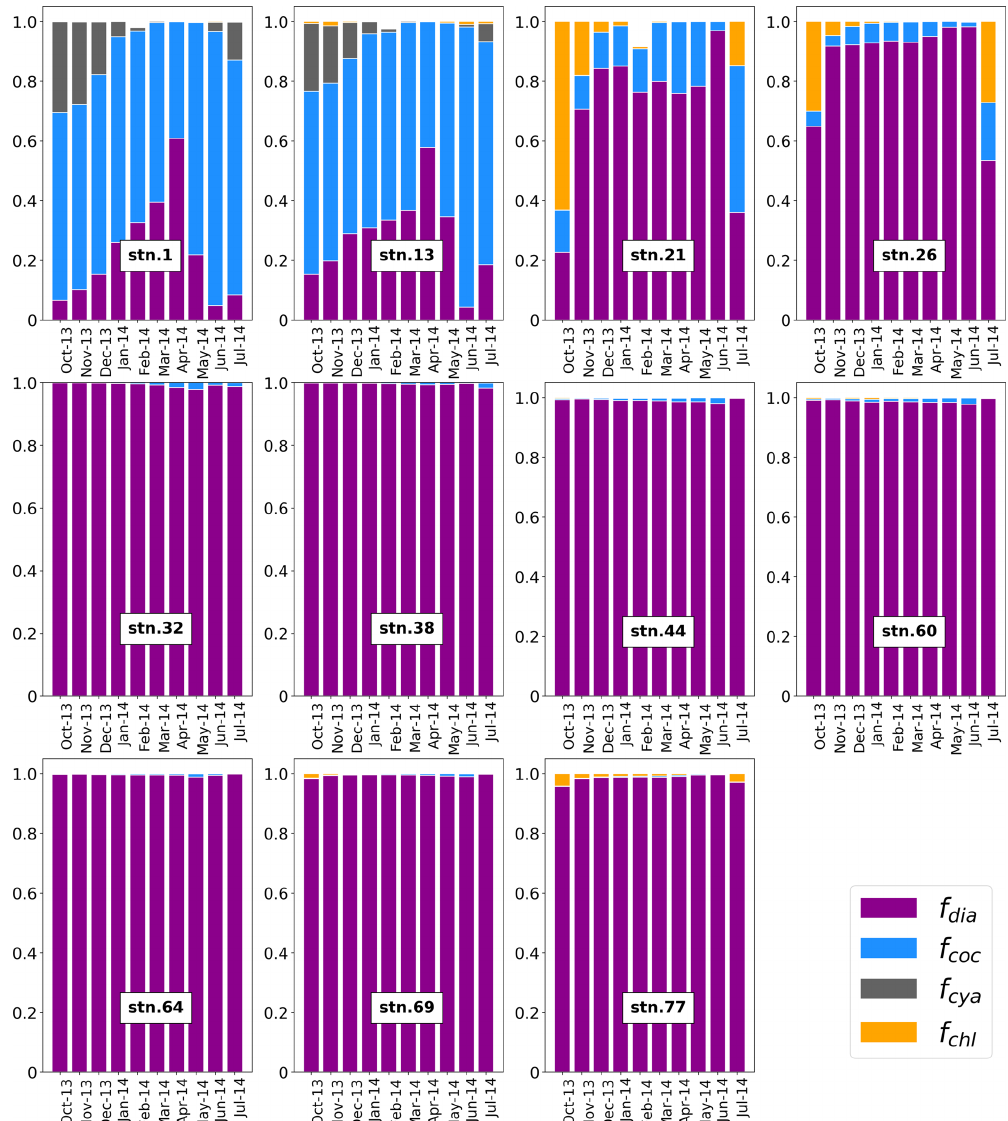
Figure 2. Satellite-derived monthly average fraction of major phytoplankton groups from October 2013 to July 2014 along the GA01 transect: f dia , f coc , f cya , and f chl are the fractions of diatoms (purple), coccolithophores (blue), cyanobacteria (gray), and chlorophytes (orange), respectively. Data are from the Giovanni online data system https://giovanni.gsfc.nasa.gov/giovanni/ (last access: 18 January